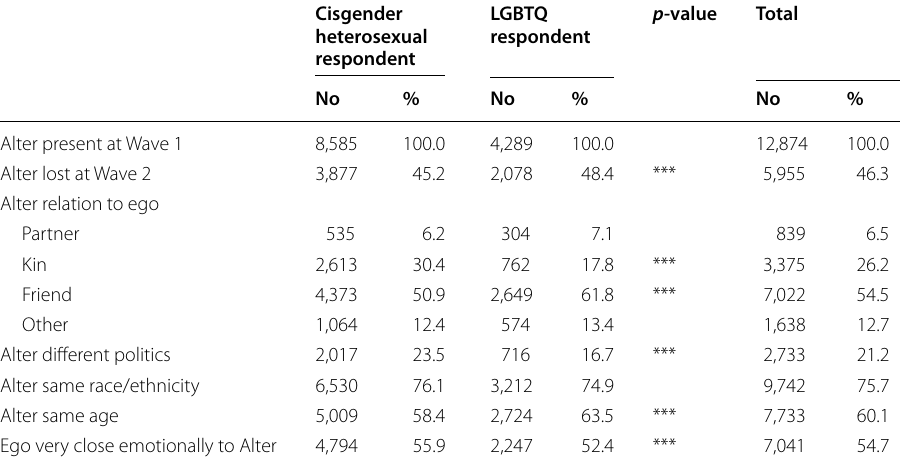
Table 2 Alter characteristics relative to respondent, by respondent sexual orientation/gender identity,